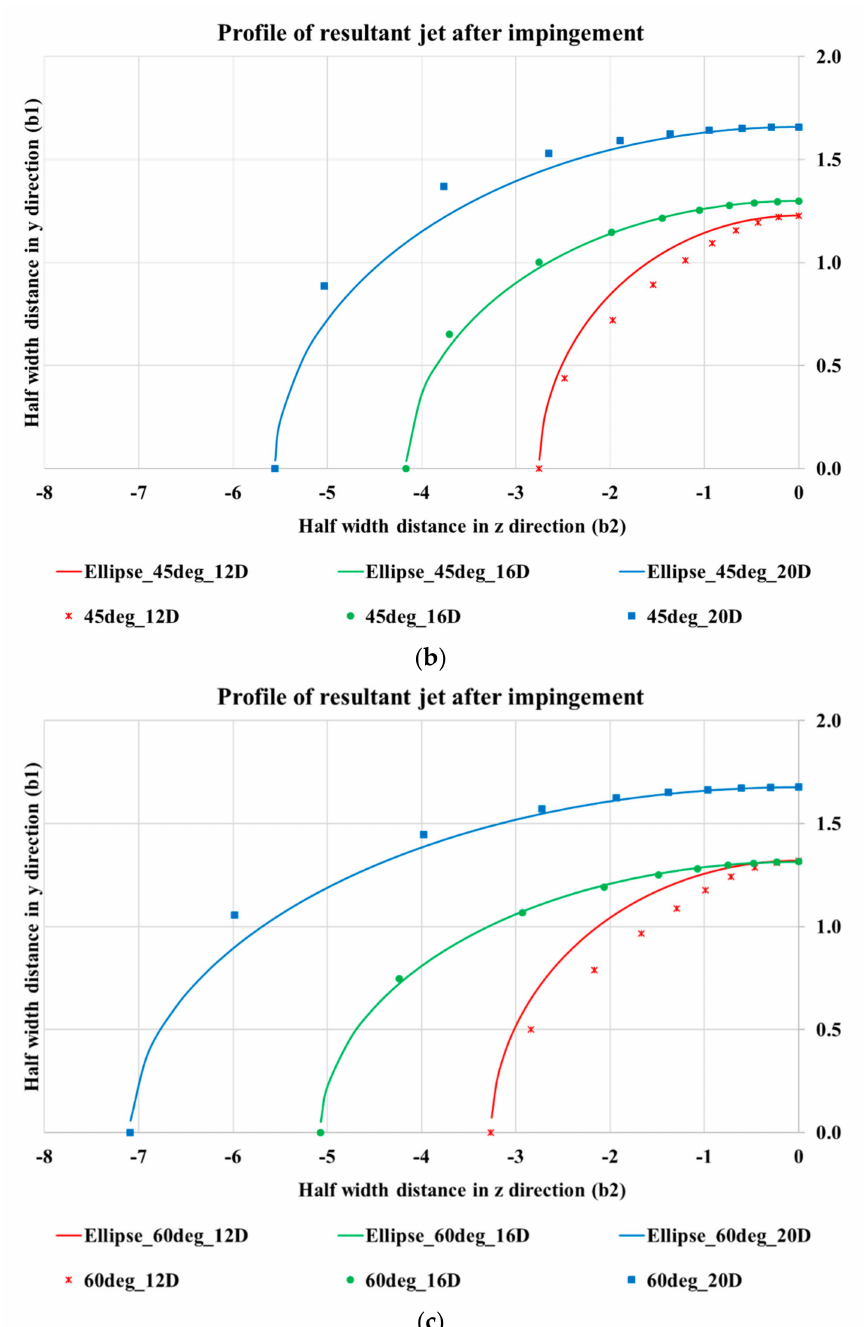
Figure 14. Comparison of velocity profile with elliptical profile at different impingement angles: ( a ) 30 degree; ( b ) 45 degree; and ( c ) 60